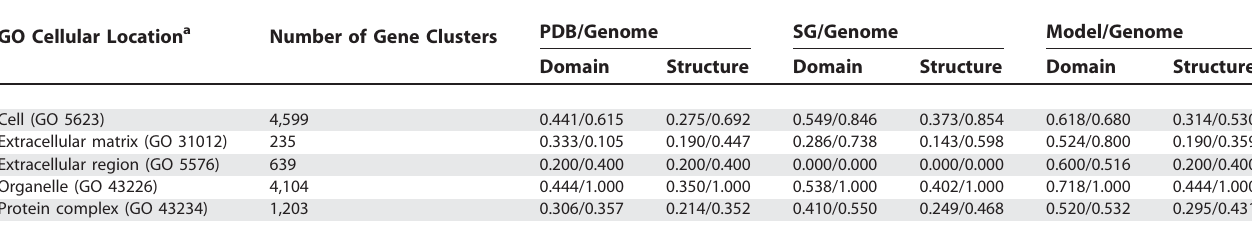
Table 4. Coverage/Kendall’s Tau Correlations for Major Categories of GO Cell Component for Both Single Domains and Whole